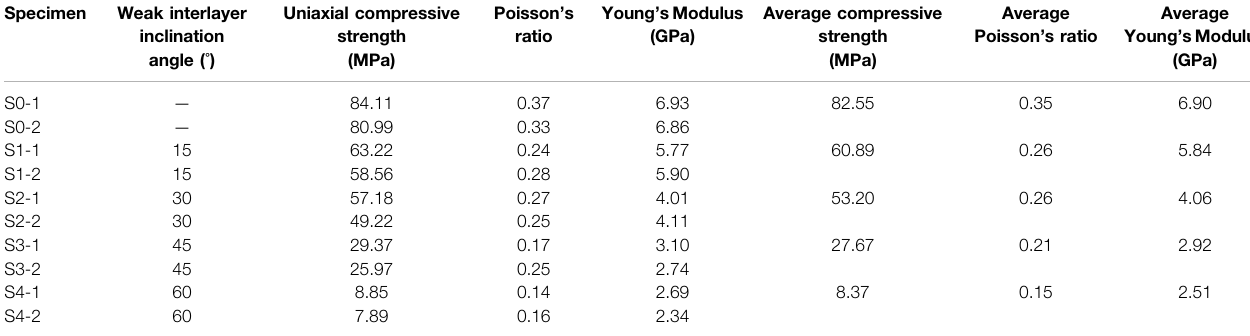
TABLE 1 | Rock mechanics parameters of specimens under uniaxial compression test. Specimen Weak interlayer